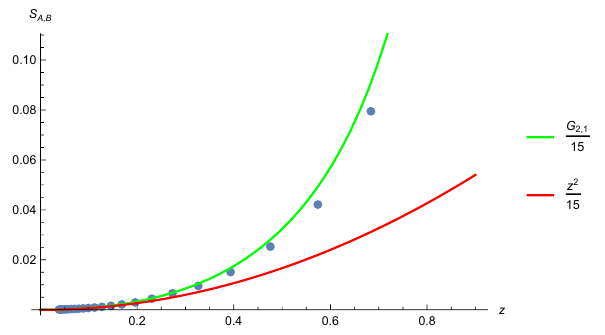
Figure 6 . Mutual information of two disks for 3 d free Dirac fermion, 0 < z < 0 : 9. The red line is the leading order contribution in z , while the green line is the leading order conformal block.